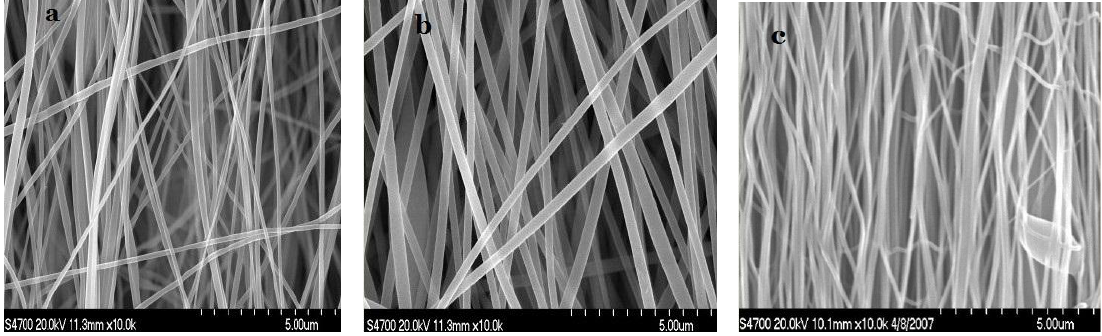
Figure 1. Scanning electron microscopy (SEM) micrographs: ( a ) as-spun pure Partially aligned polyacrylonitrile (PAN) nanofibers; ( b ) PAN/ single-walled carbon nanotubes (SWNTs) composite nanofibers with SWNTs concentration 1 wt%; ( c ) hot-stretched pure PAN nanofibers.